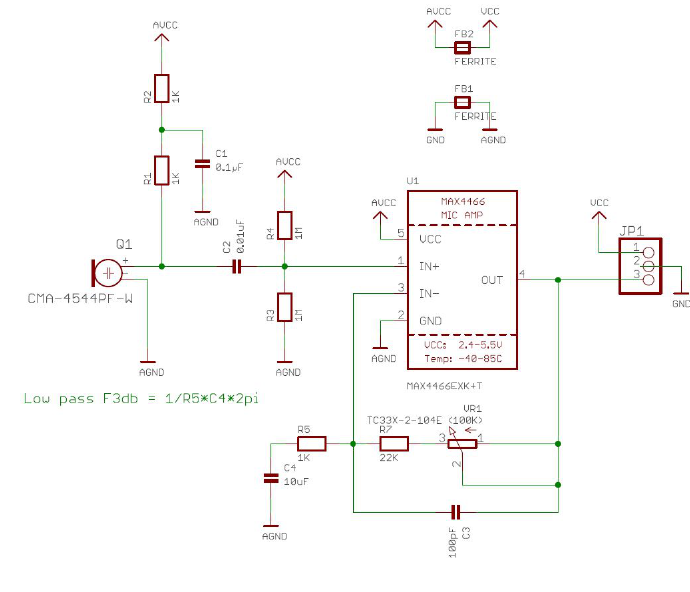
Figure 1. Schematic of audio sensor.